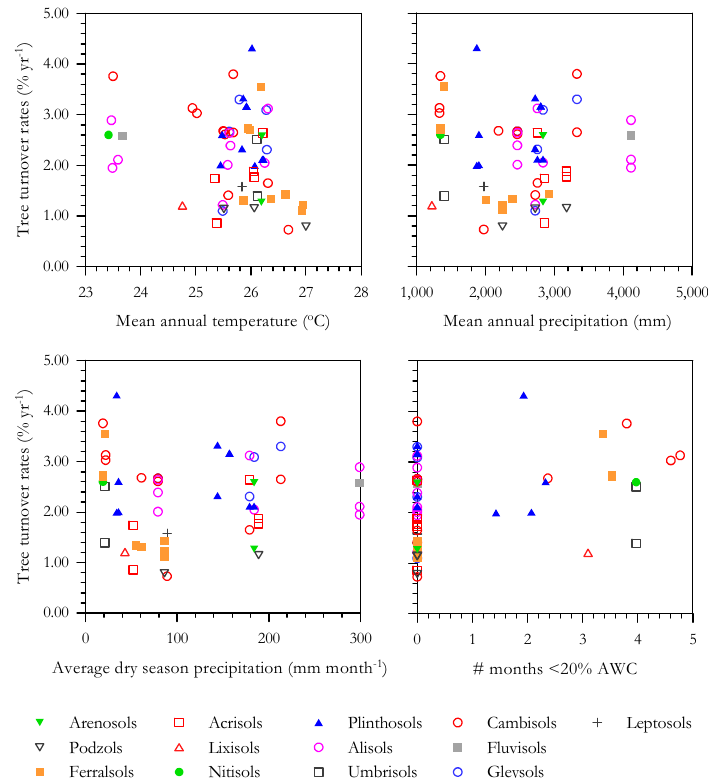
Fig. 11. Relationships between tree turnover rates and climatic